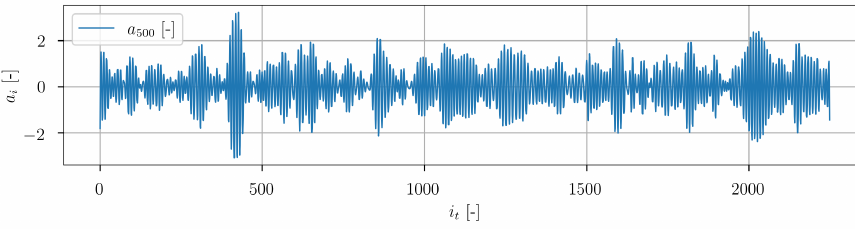
Figure 23. Temporal POD coefficient of mode 500 over the snapshot index.